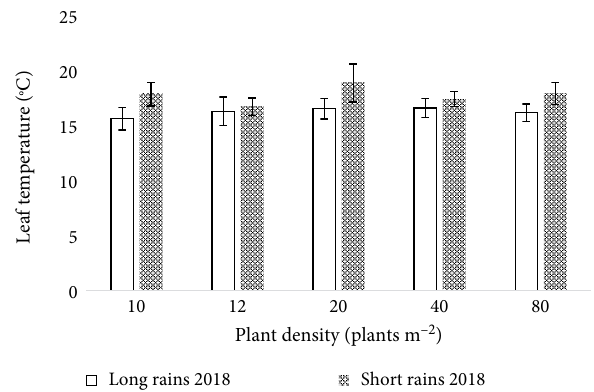
Figure 4: Effect of plant density on leaf temperature at 50% flowering stage. Vertical bars represent ± standard error. Values significantly different at 푝 < 0.05 .